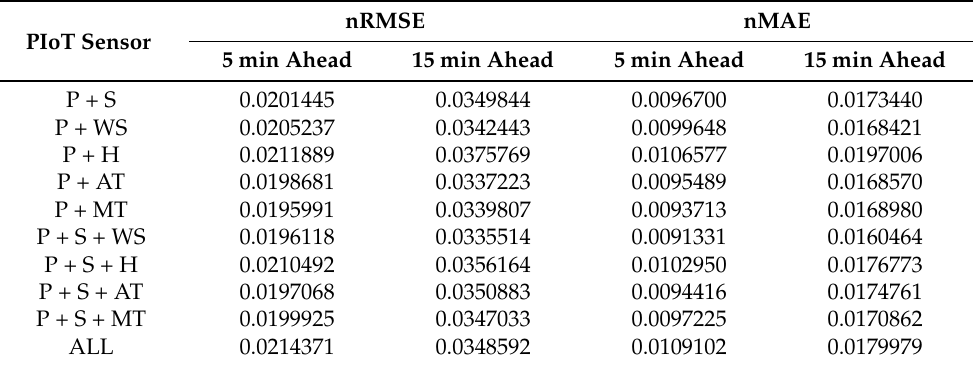
Table 5. Very short-term forecasting errors according to PIoT sensors: P (Power), Solar (S), Wind Speed (WS), Humidity (H), Ambient Temperature (AT), Module Temperature (MT). nRMSE PIoT Sensor